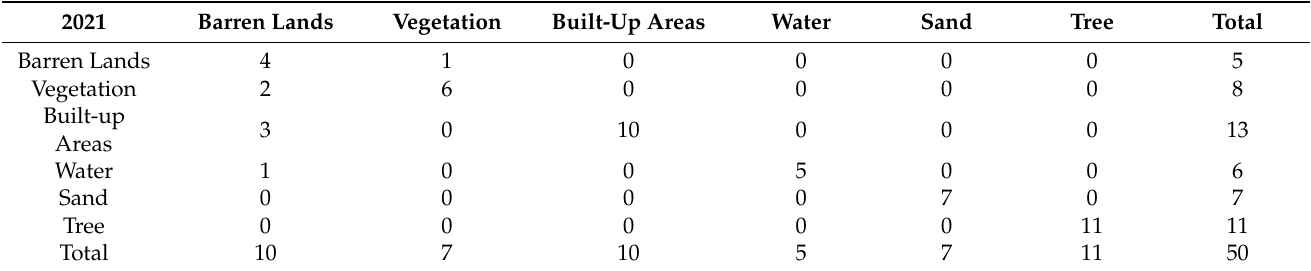
Table 2. Error matrix of land use classification for